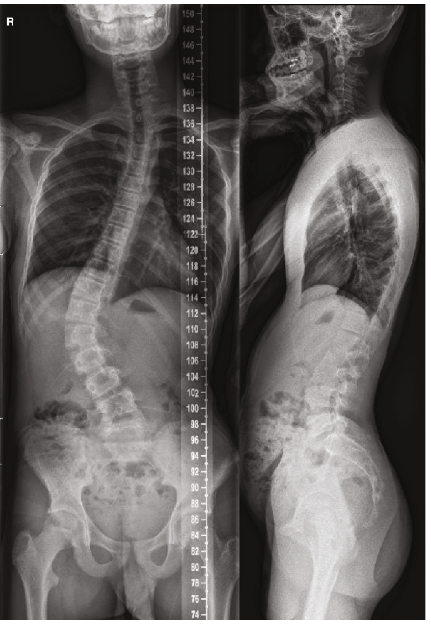
Figure 3: Whole spine plain radiograph. AP and lateral view when surgery was decided for the patient, at December 28 th , 2015.